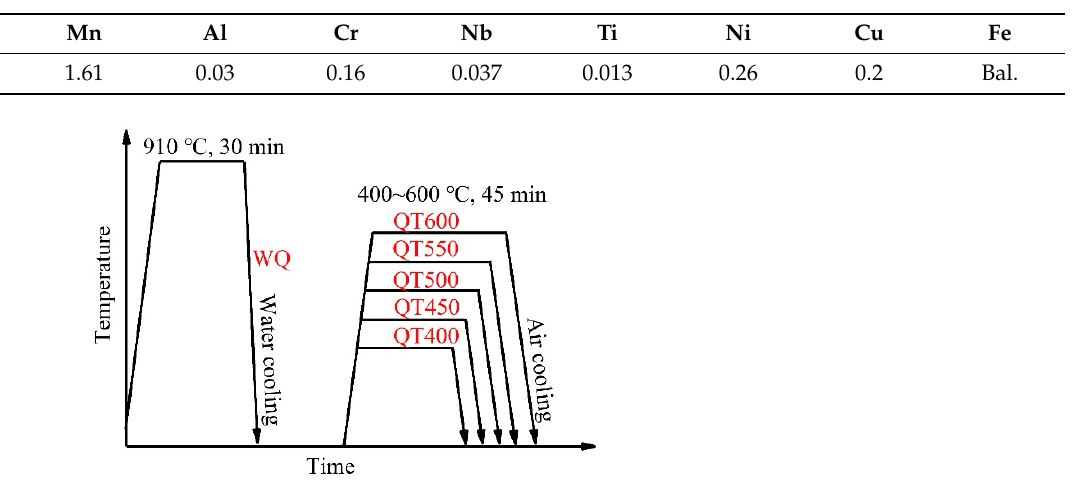
Figure 1. Schematic diagrams of heat treatment. According to the GB/T 228.1-2010 standard, tensile tests of plate specimens (gauge length = 25 mm) were carried out on an electronic universal tensile testing machine. According to the GB/T 229-2007 standard, Charpy V-notched impact specimens of 10 mm × 10 mm × 55